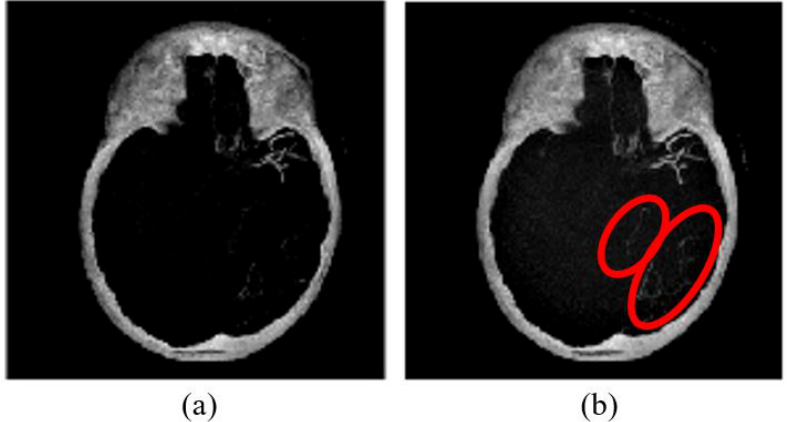
Figure 6. MIP image ( a ) without brightness adjustment prior to HU conversion in comparison to ( b ) with brightness adjustment prior to HU